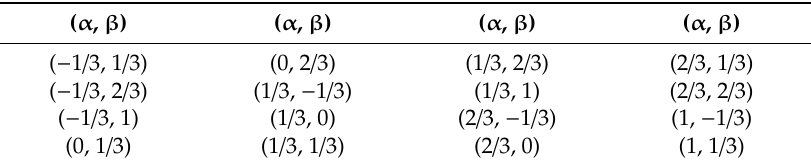
Table 2. Pairs of the scale factors ( α and β ).